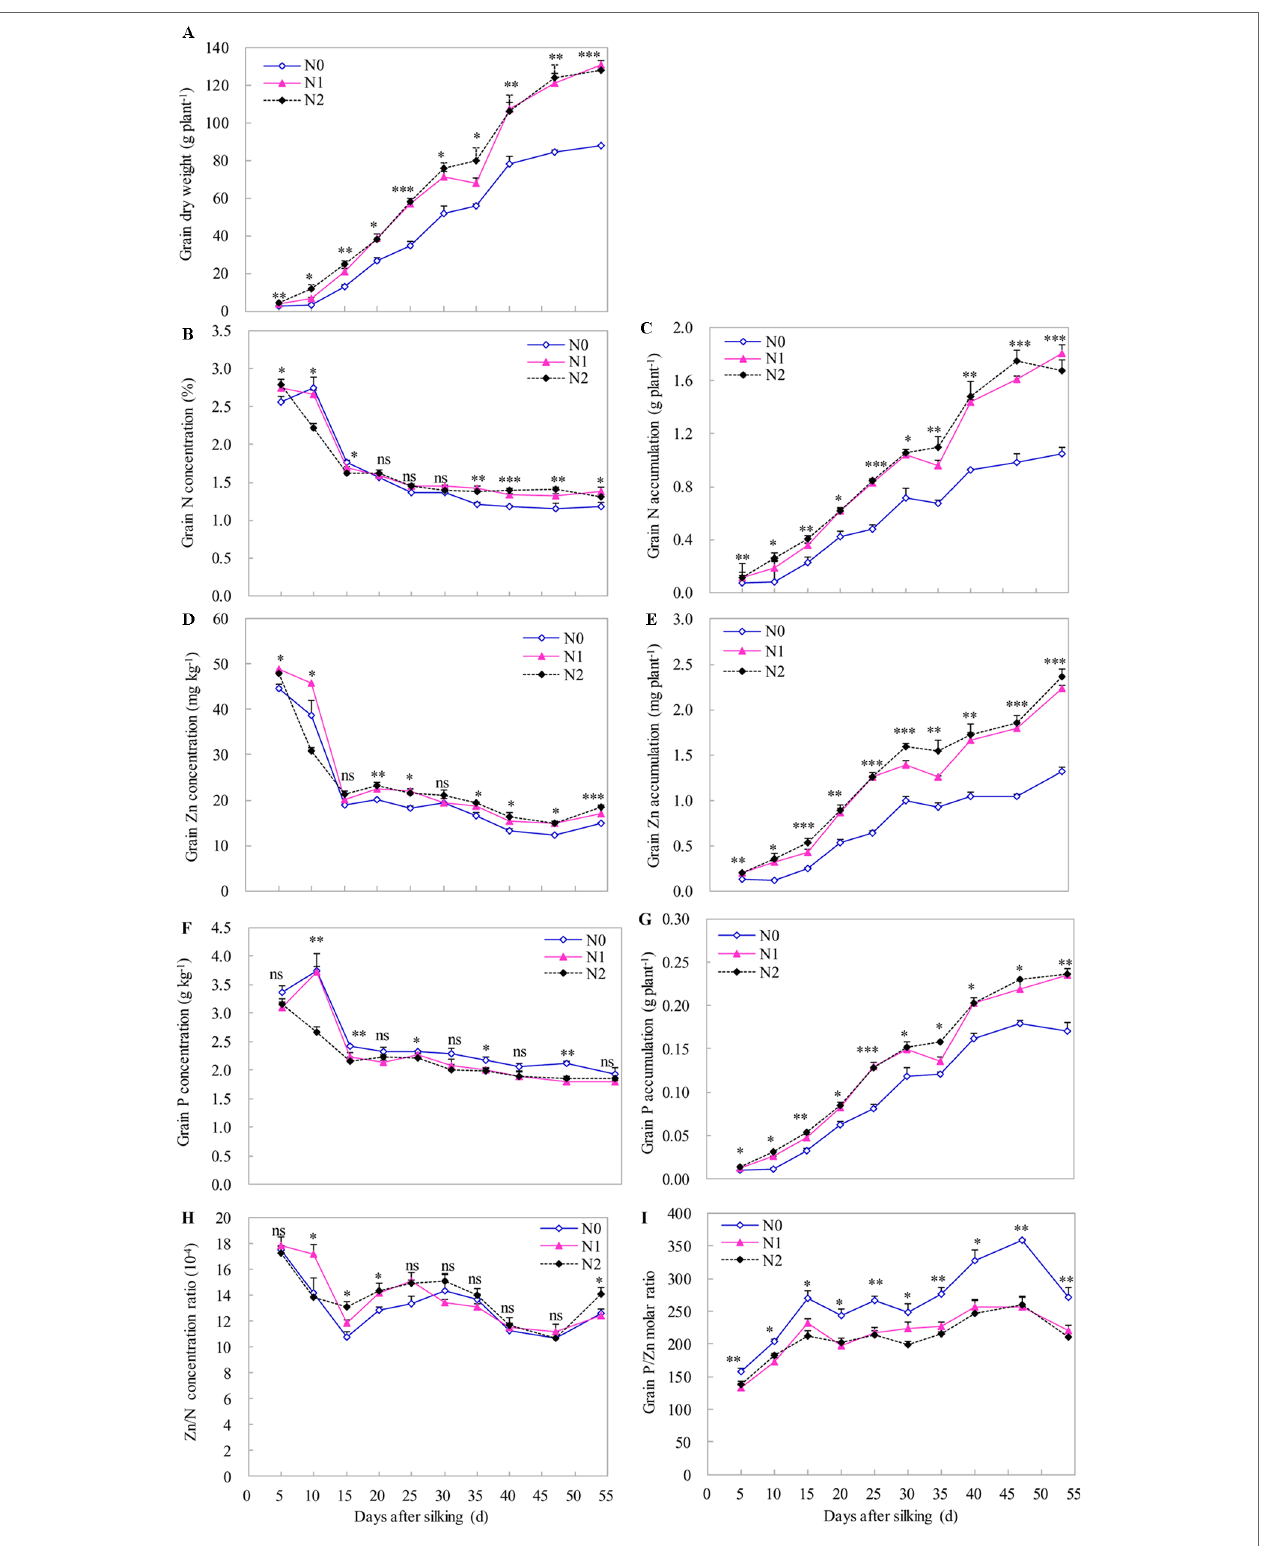
FIGURE 5 | The dynamics of grain dry weight (A) , N, Zn and P concentration (B , D , F) and accumulation (C , E , G) , the ratios of Zn to N accumulation (H) and the molar ratio of P to Zn (I) during the grain development in 2009. The error bars represent the standard error of the mean ( n = 4). ns indicates no significant difference. *, **, and *** indicate significant difference at P < 0.05, < 0.01, and < 0.001,